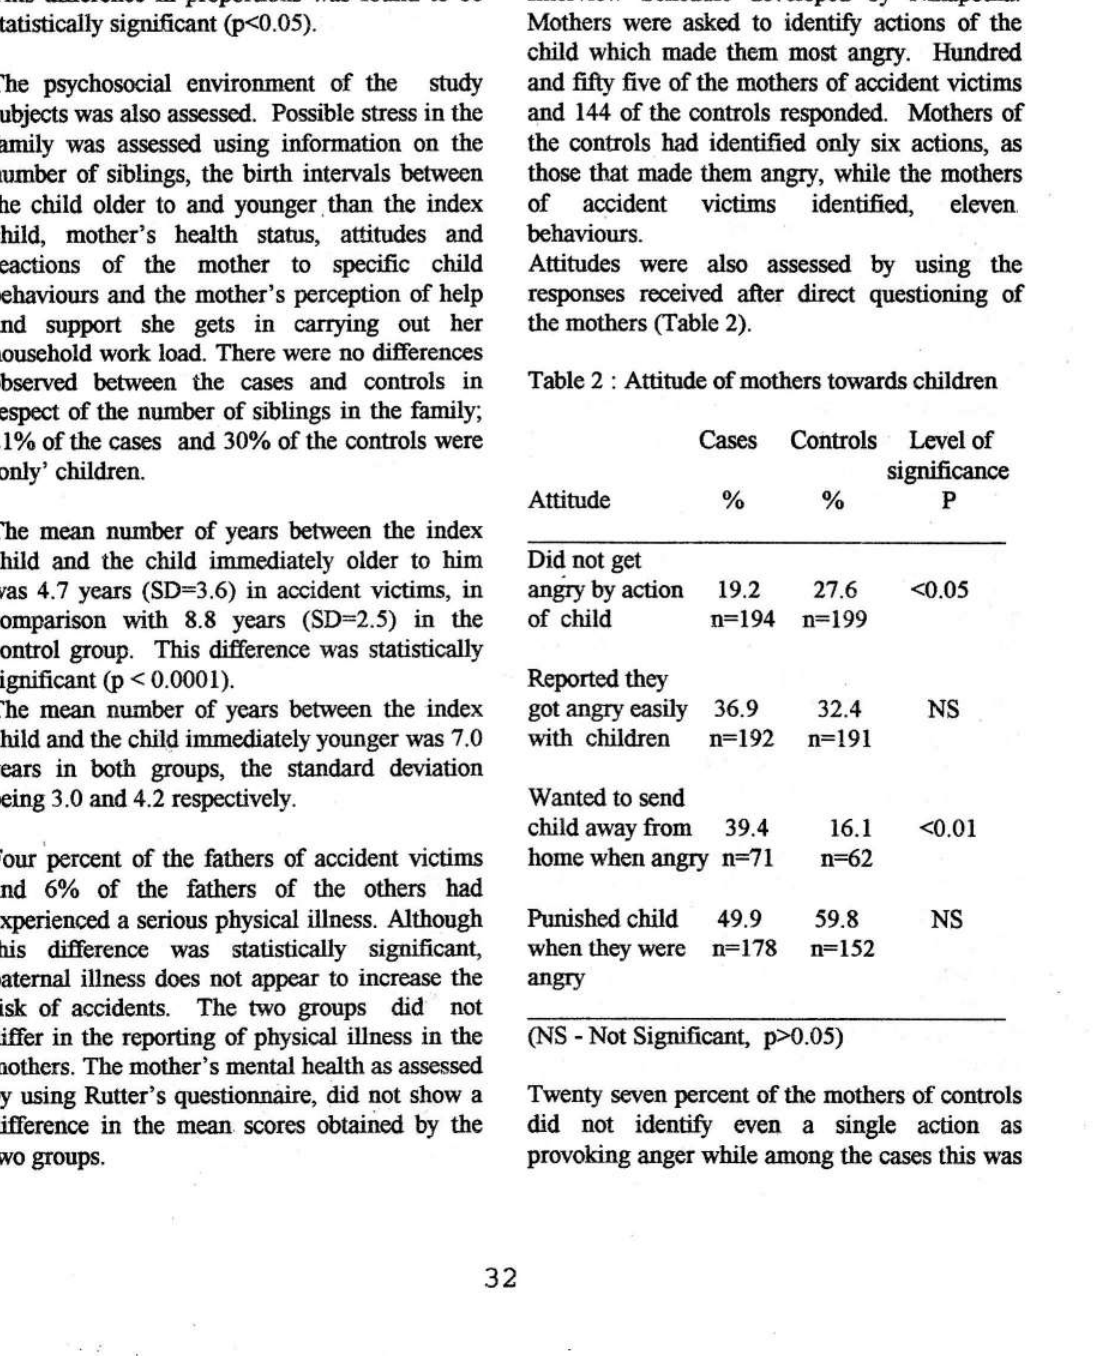
Table 2 : Attihrde of mothers tovards